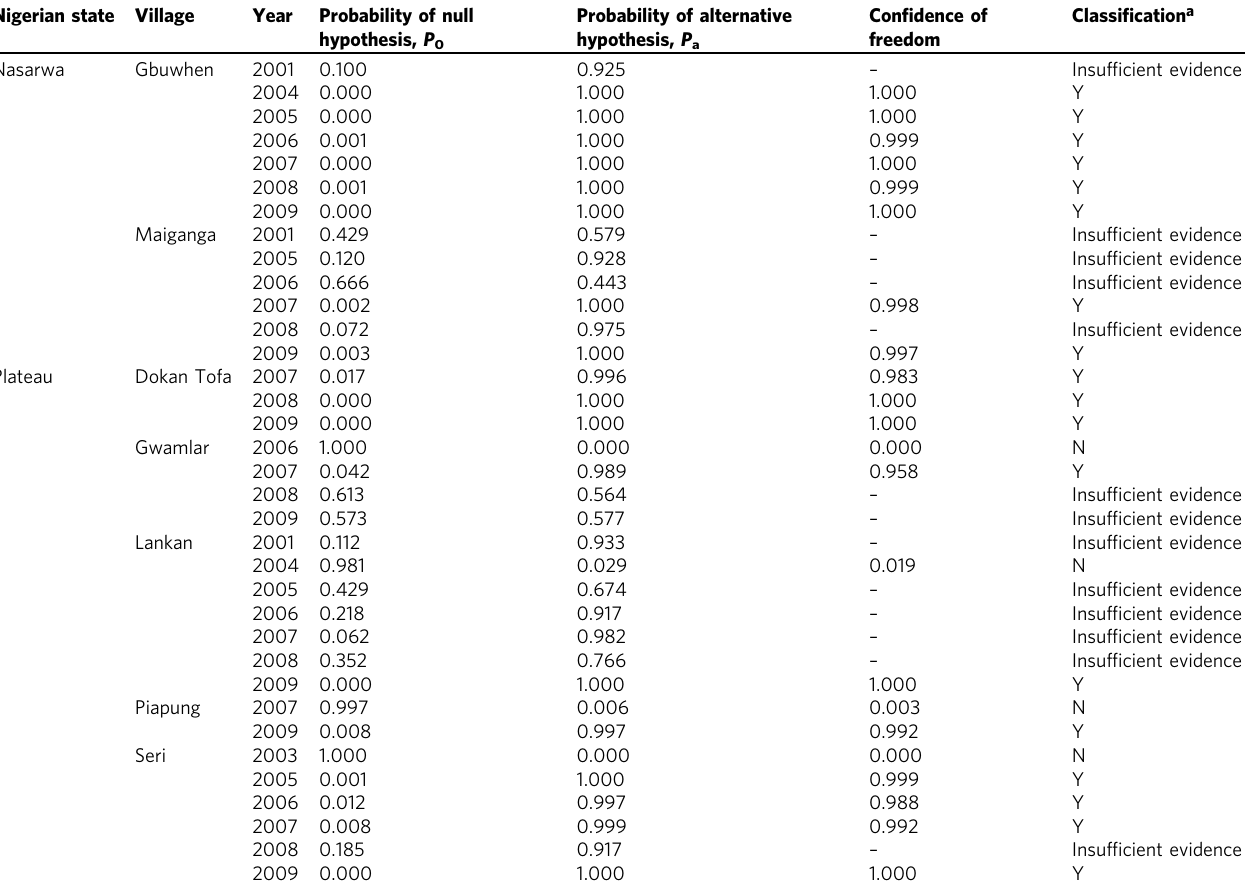
Table 4 Results from the LF PFFI